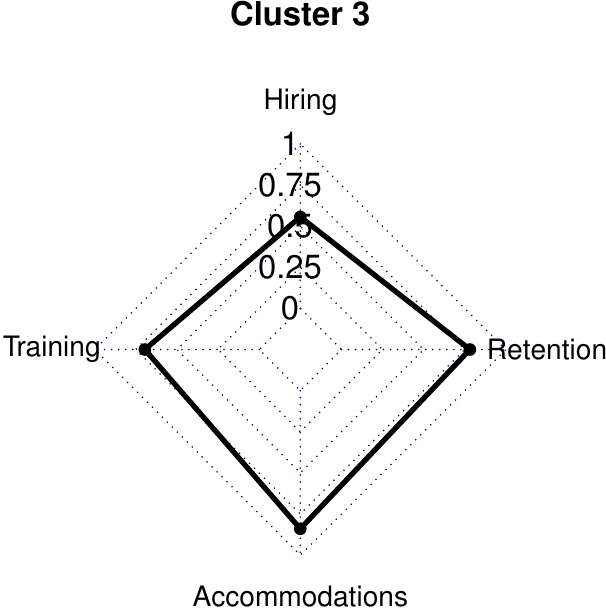
Figure 4. Cluster 3 radar